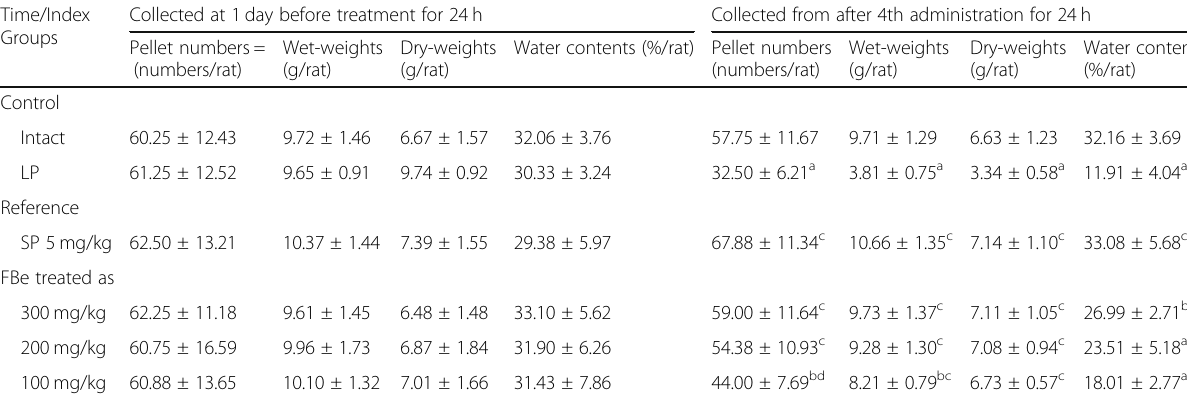
Table 3 Fecal parameters in the constipation rats induced by LP Time/Index Groups